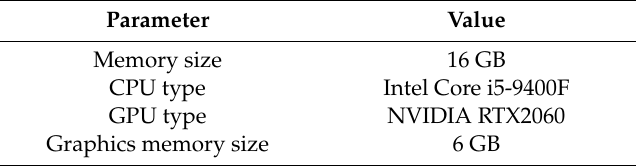
Table 1. The specifications of the computer used in the experiment.